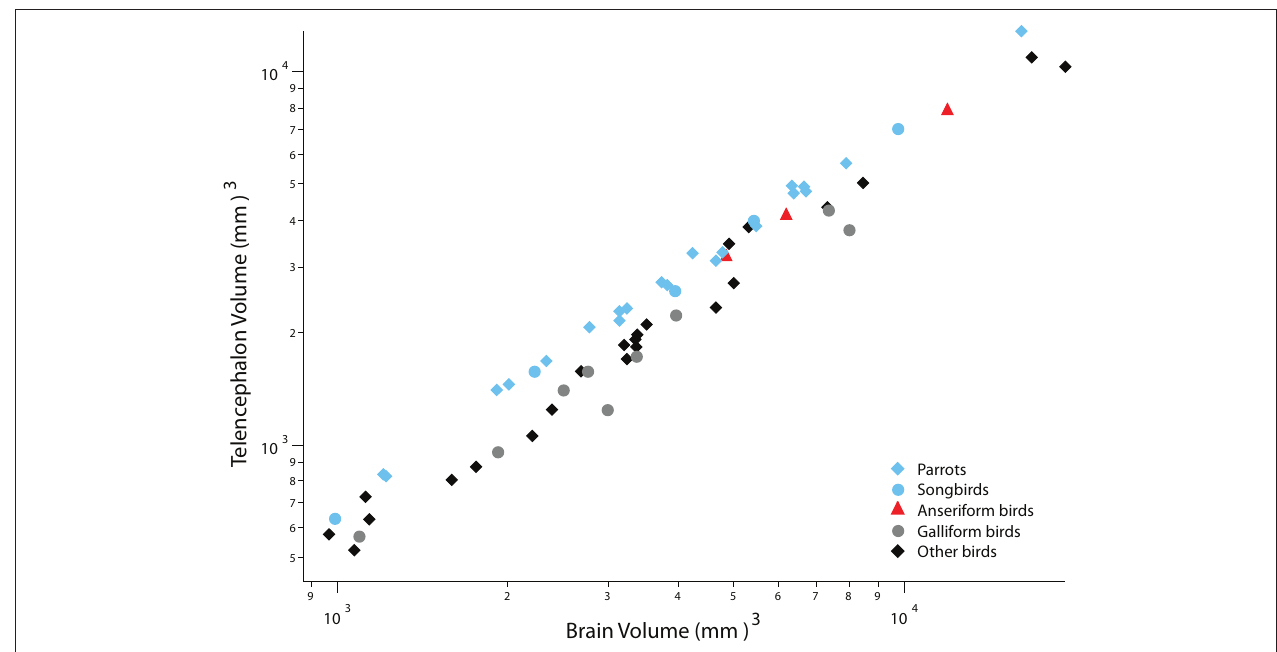
Figure 1 | A plot of telencephalon volume versus overall brain volume shows that the telencephalon is disproportionately large in parrots, songbirds (i.e., oscine passerines), and anseriform birds (ducks and geese) compared with galliform birds and diverse other avian species . The other avian species in this graph include mainly pigeons, shorebirds and falcons. Data are from Iwaniuk and Hurd (2005).